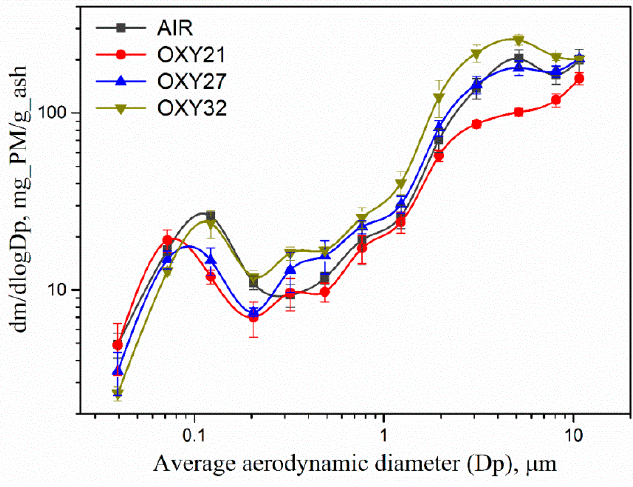
Figure 3. Mass-based particle size distributions (PSDs) of PM 10 during the air and oxy-fuel combustion of Zhundong coal.